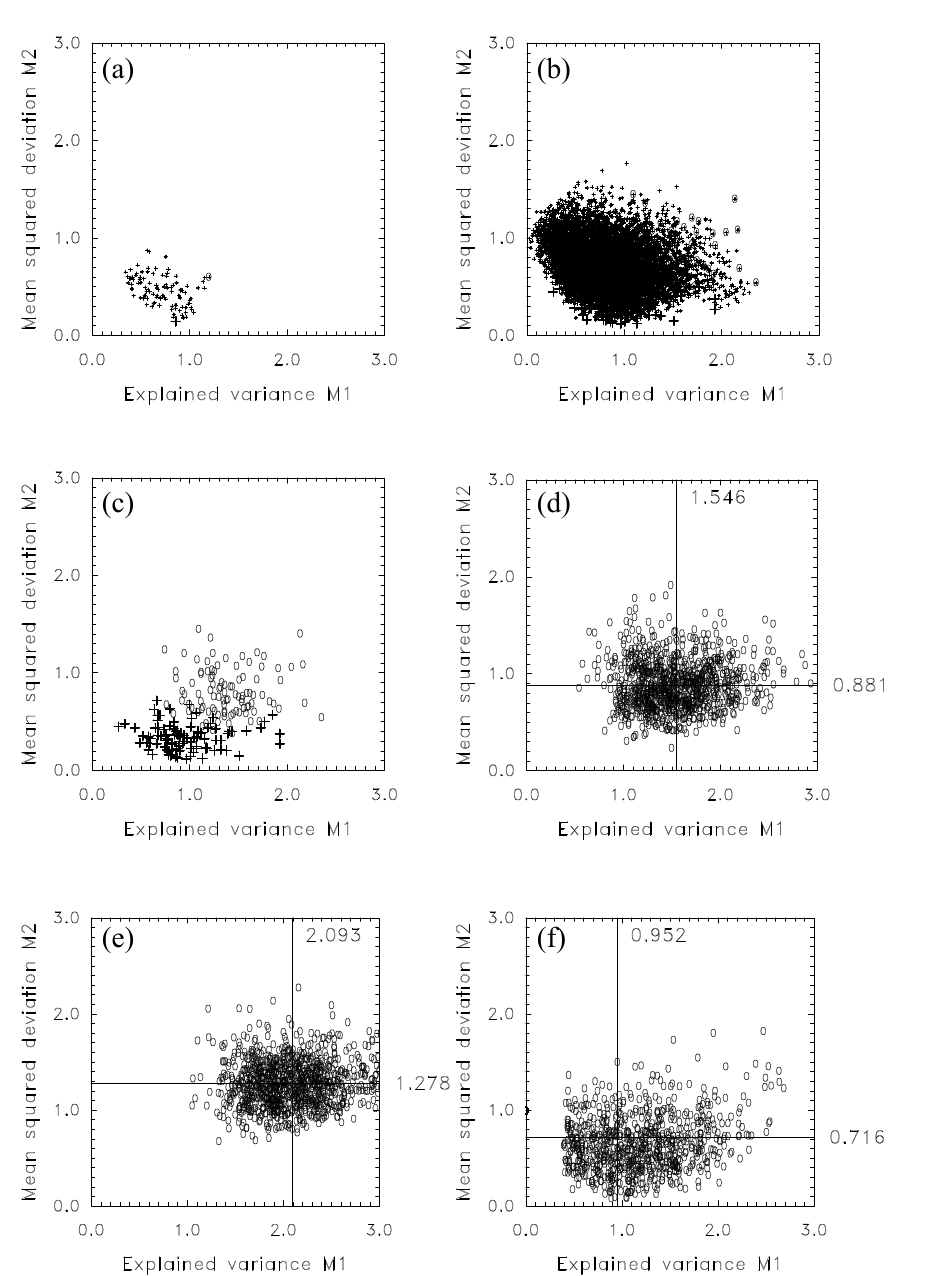
Figure 11. Mean squared signal deviation (M2) against explained variance of the noisy data (M1). These two measures are given for random segmentations of simulated time series of length 100 with SNR = 1 / 2, with seven true and seven tested breaks. (a) 100 random segmentations of a single time series. (b) As panel (a) , but for 100 segmentations of 100 time series. (c) As panel (b) , but only for the maxima with respect to the explained variance (0) and with respect to the true skill ( + ). (d) As panel (c) , but the number is increased from 100 by 100 to 1000 by 1000 and only the maxima with respect to the explained variance (0) are drawn. The horizontal and vertical lines give the means for the two axes. (e) As panel (d) , but here the maximum explained variance is searched by optimal partitioning (without a stop criterion) instead of just choosing the best of 1000. (f) As panel (e) , but for the full search method (optimal partitioning plus a stop criterion). The estimated break number is no longer fixed to be seven, but is defined by the stop criterion given in Eq.